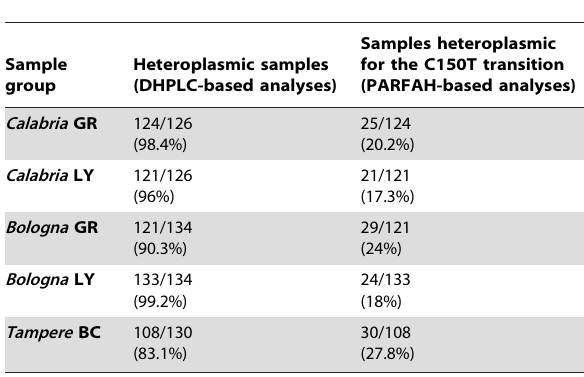
Table 1. Proportion of samples heteroplasmic for the C150T